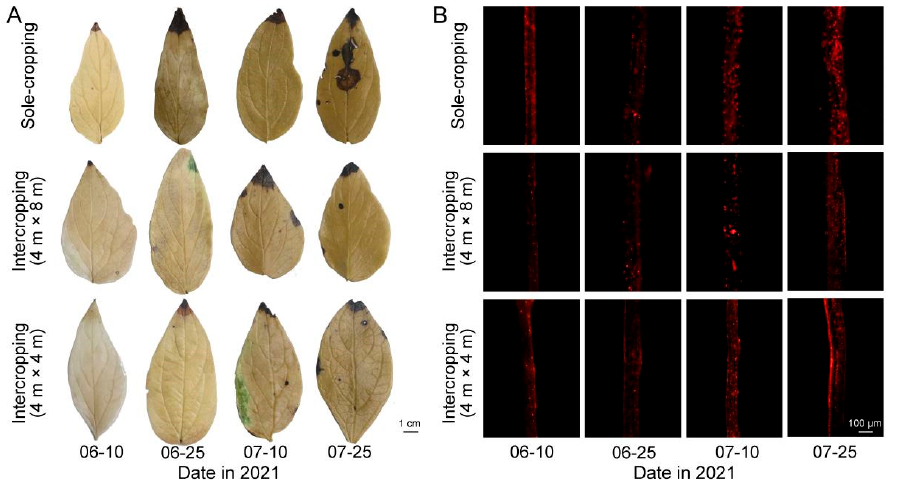
Figure 2. Effects of understory cultivation on the ROS accumulation level of P. ostii : ( A ) the accu- mulation level of H 2 O 2 ; ( B ) the accumulation level of O 2· −